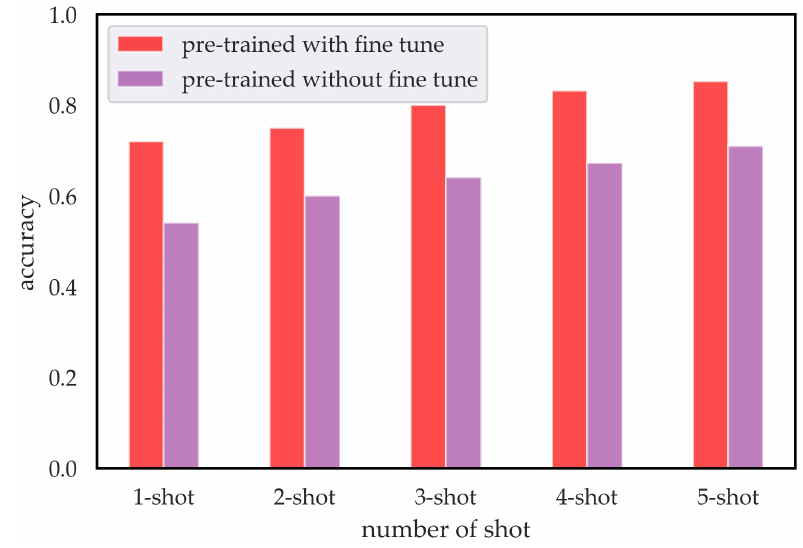
Figure 6. Accuracies with different shots tested on NWPU-RESISC45